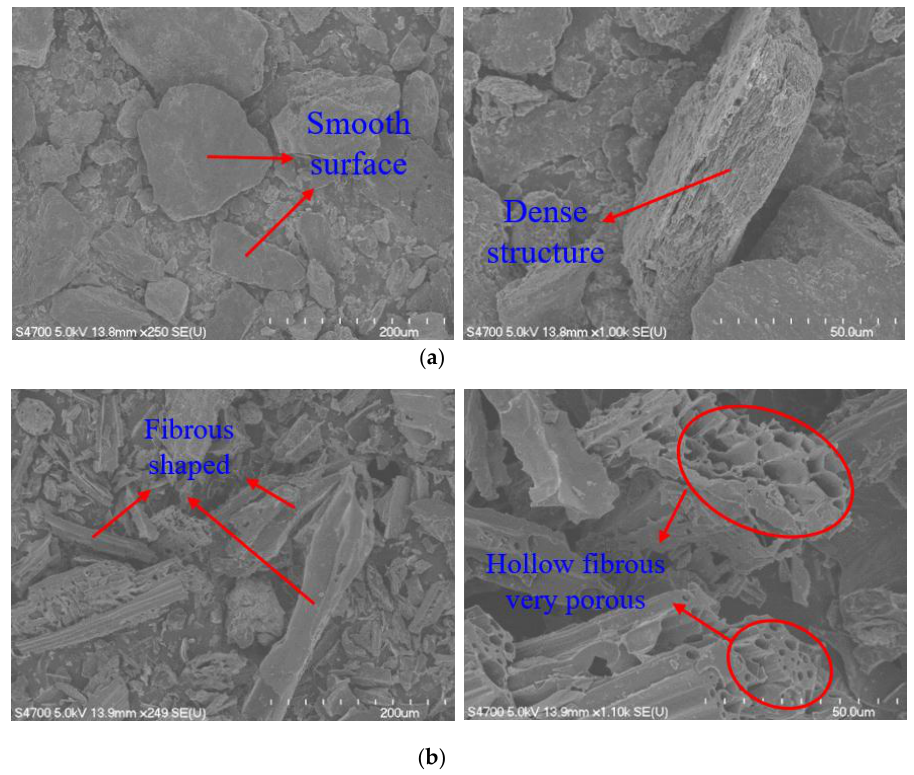
Figure 1. ( a ) Images of graphite magnified by SEM; ( b ) images of bio-char magnified by SEM.